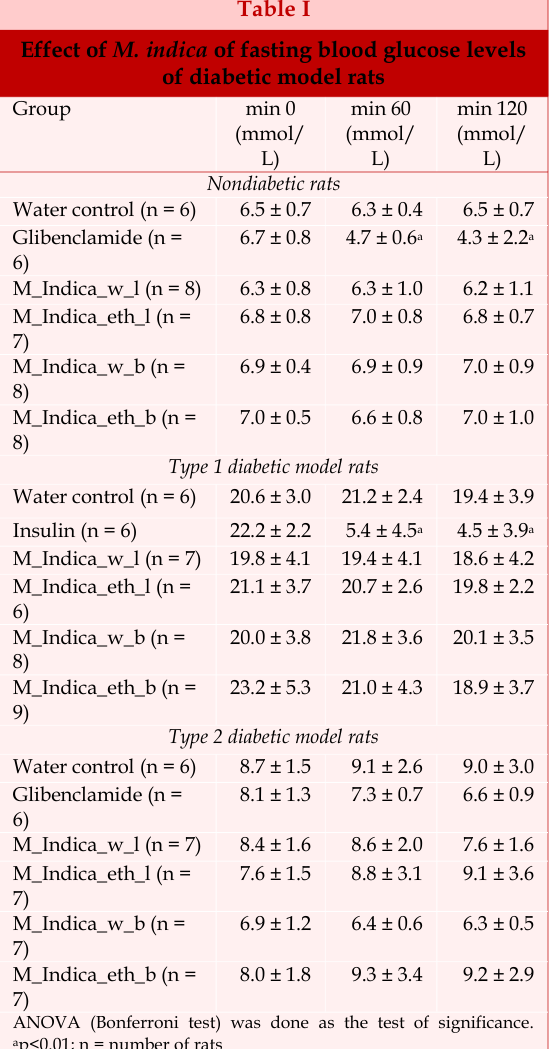
Effect of M. indica on blood glucose levels diabet- ic model rats when the extracts were fed simulta- neous with glucose